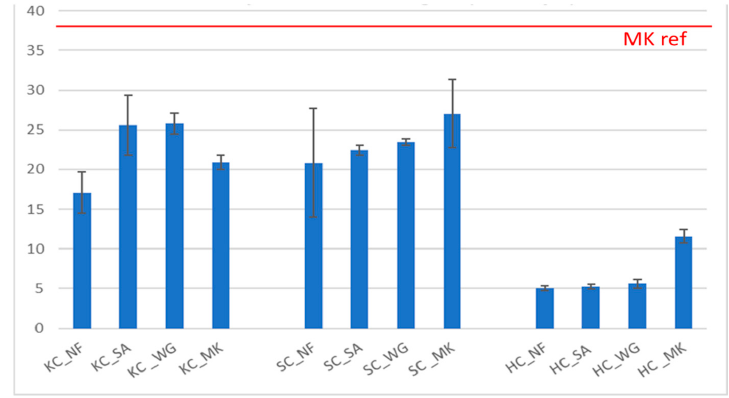
Figure 5. Compressive strength results of the geopolymers aged 28 days. The line MK ref indicates the compressive strength of reference geopolymer based on 100% metakaolin.